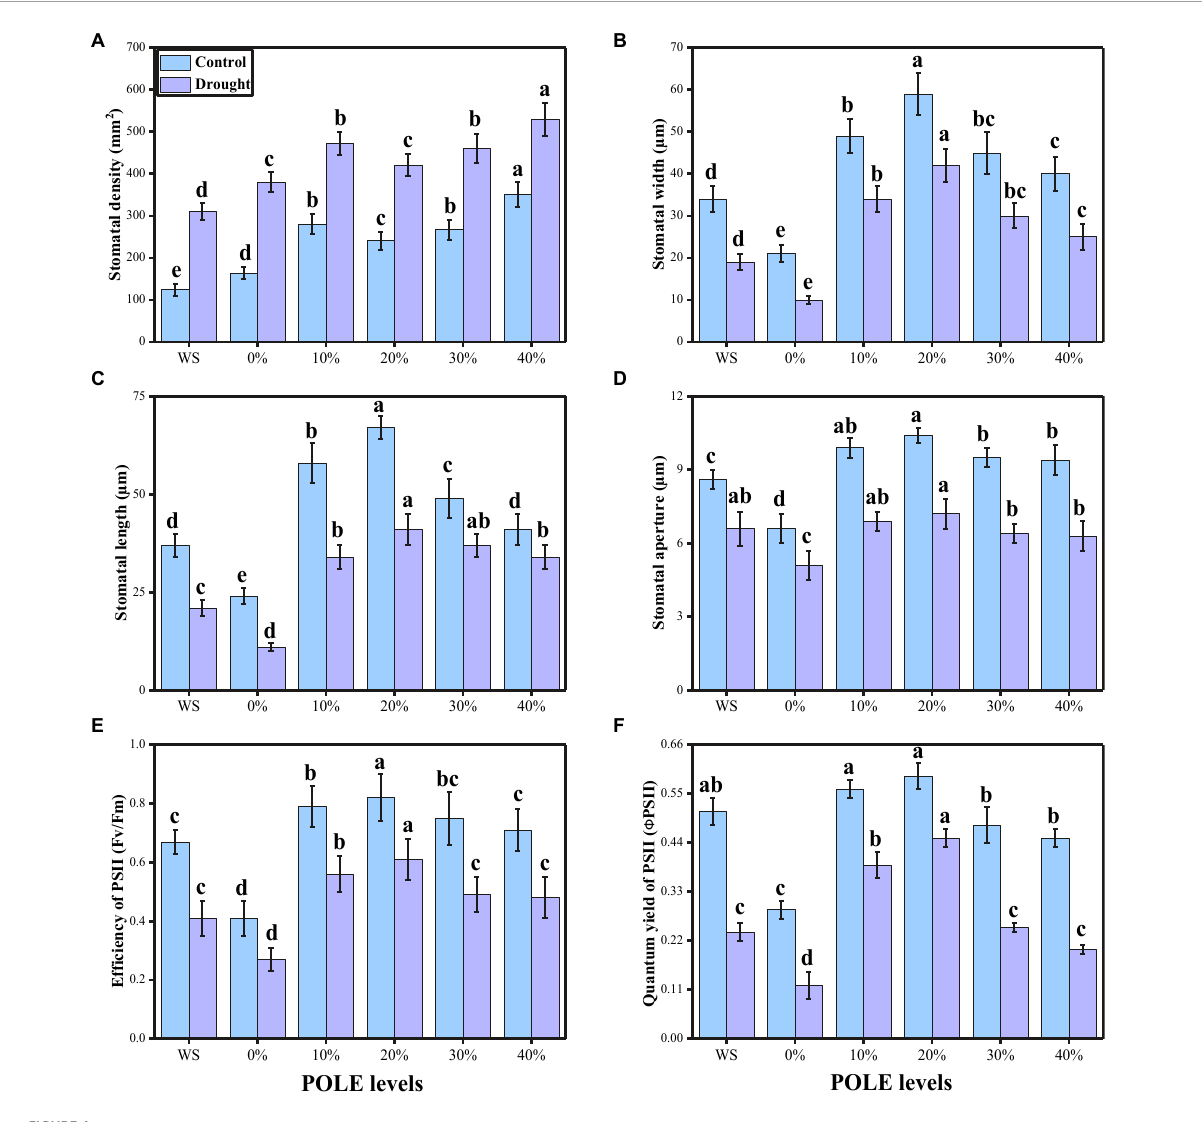
FIGURE4 Effect of seed priming with Plantago ovata Forsk leaf extract (POLE) on stomatal density (A) , stomatal width (B) , stomatal length (C) , stomatal aperture (D) , efficiency of PSII (E) , and quantum yield of PSII (F) under well-watered and drought stressed environment in wheat. Means sharing similar letter(s) within a column for each parameter do not differ significantly at P < 0.05. Data in the figures are means of four repeats ( n = 4) of just one harvest of wheat plants ± standard deviation (SD). Different lowercase letters on the error bars indicate significant difference